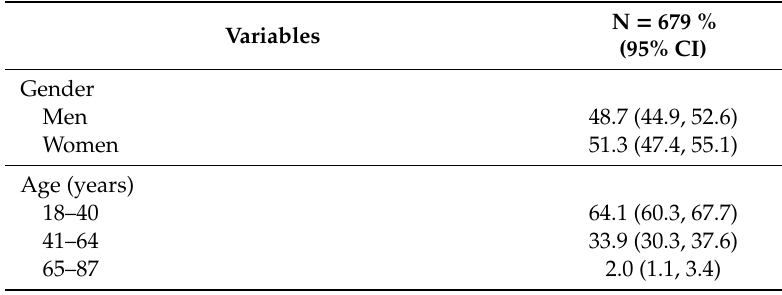
Table 1. Characteristics of the Move on Bikes (by its name in Spanish Mu é vete en Bici) (MEB) program participants and a description of what they were doing while participating in the program. M é xico City,